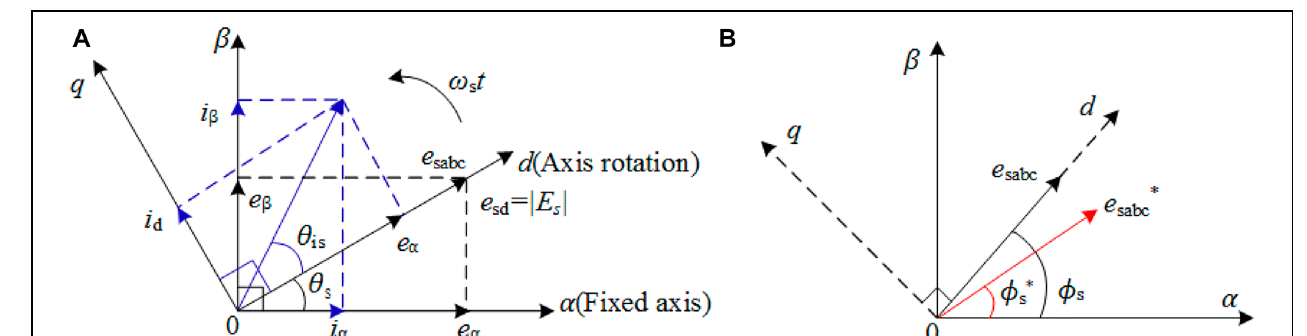
FIGURE 2 | The vector graph: (A) voltage orientation control; (B) phase-locked